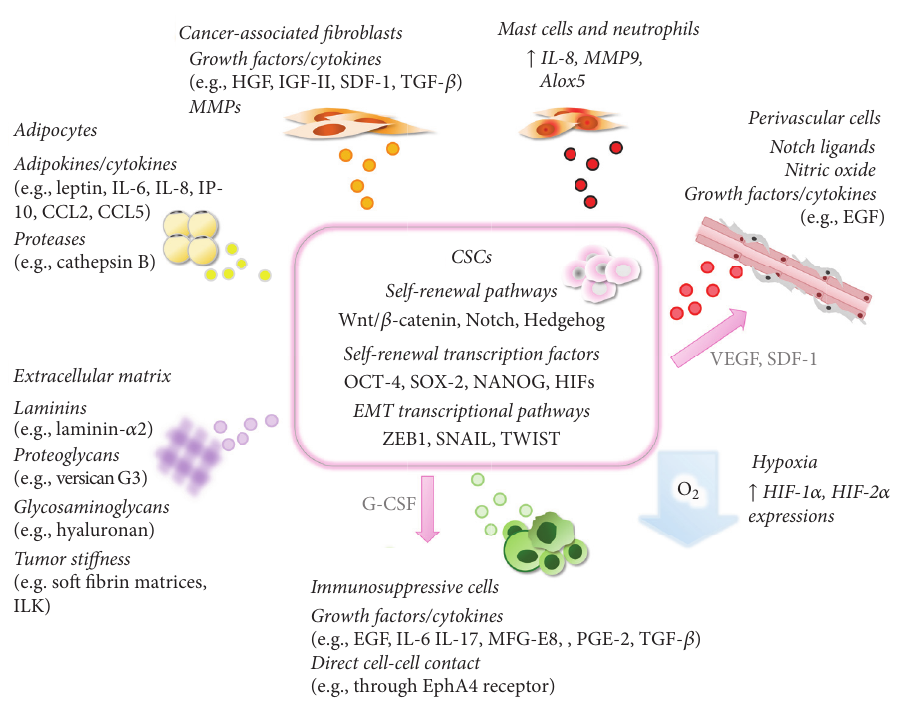
Figure 1: The cross talks between CSCs and their niches. CSCs reside in their habitats, which are specific microenvironments within the tumor consisting of CAFs, masts cells, neutrophils, perivascular cells, adipocytes, ECM, and immune-suppressive cells, as well as hypoxia. By providing various paracrine factors or via direct cell-cell contact, these niches play a crucial role in maintaining CSC plasticity by regulating pathways or transcription factors involved in self-renewal or EMT process. Reciprocally, CSCs can actively recruit some of these niche components to create a microenvironment that is favorable for its survival. For example, CSCs can secrete VEGF and SDF-1 to recruit perivascular cells or produce G-CSF to recruit MDSCs into the tumor